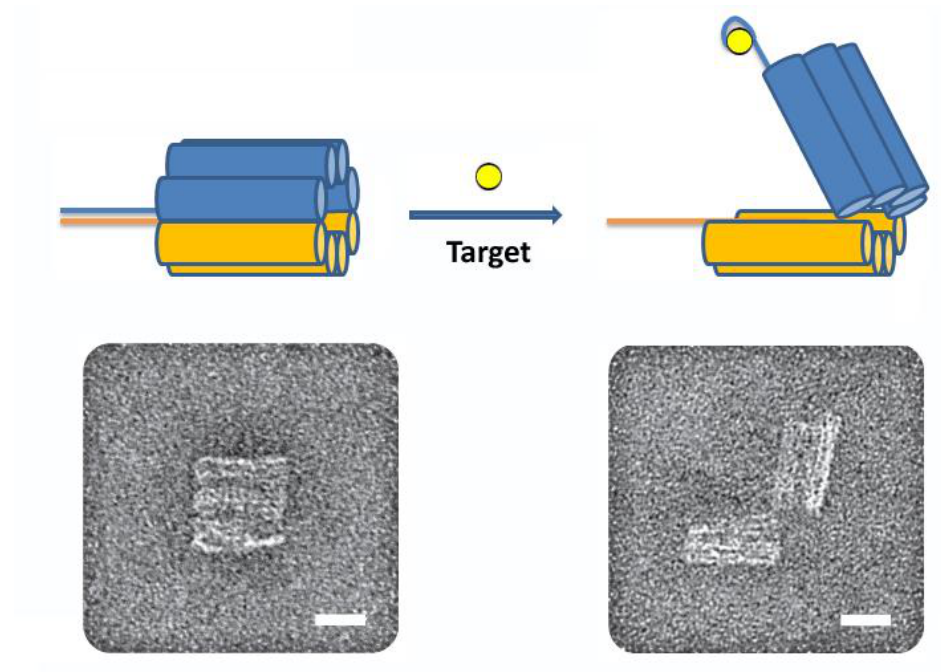
Figure 6. Aptamer-gated DNA nanorobot. Top: Schematic of the nanorobot. A DNA origami-based hexagonal barrel is held together at the front by staples modified with DNA-aptamer-based locks. The robot is opened by target displacement of the aptamer locks. Bottom: TEM images of robots in closed and open conformations (Scale bars = 20 nm) (modified from reference